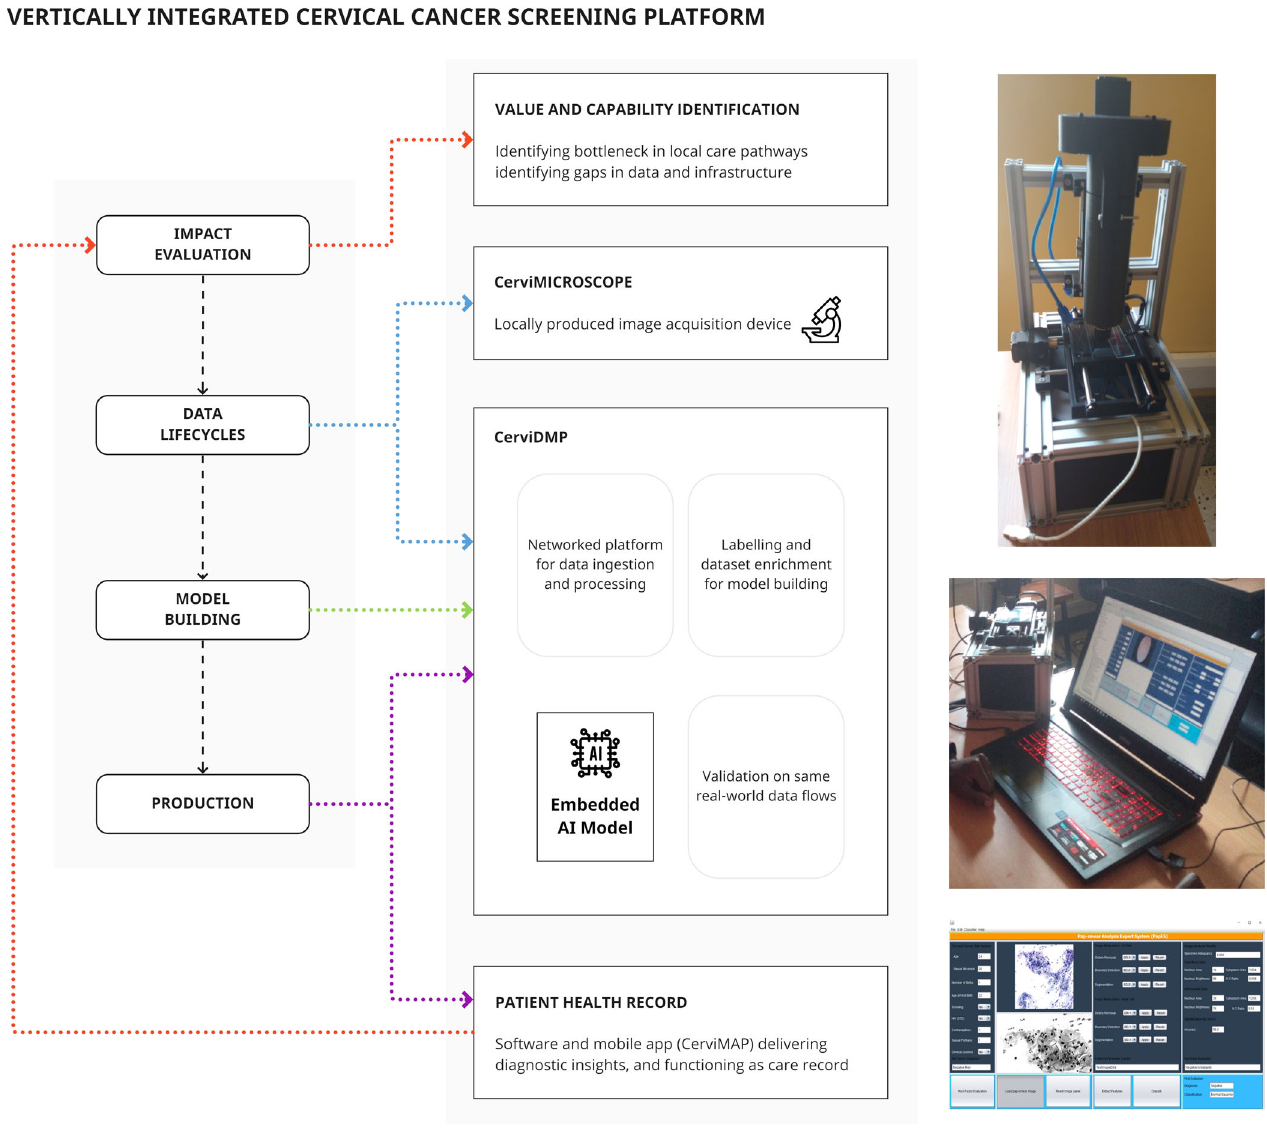
Fig. 5 Vertical integration in a cancer screening platform includes parallel development of data and production infrastructure to support model training and implementation. In contrast to Fig. 4, a focus on building supply chain components that support a predictive model will ensure that the model can be operationalized in the real